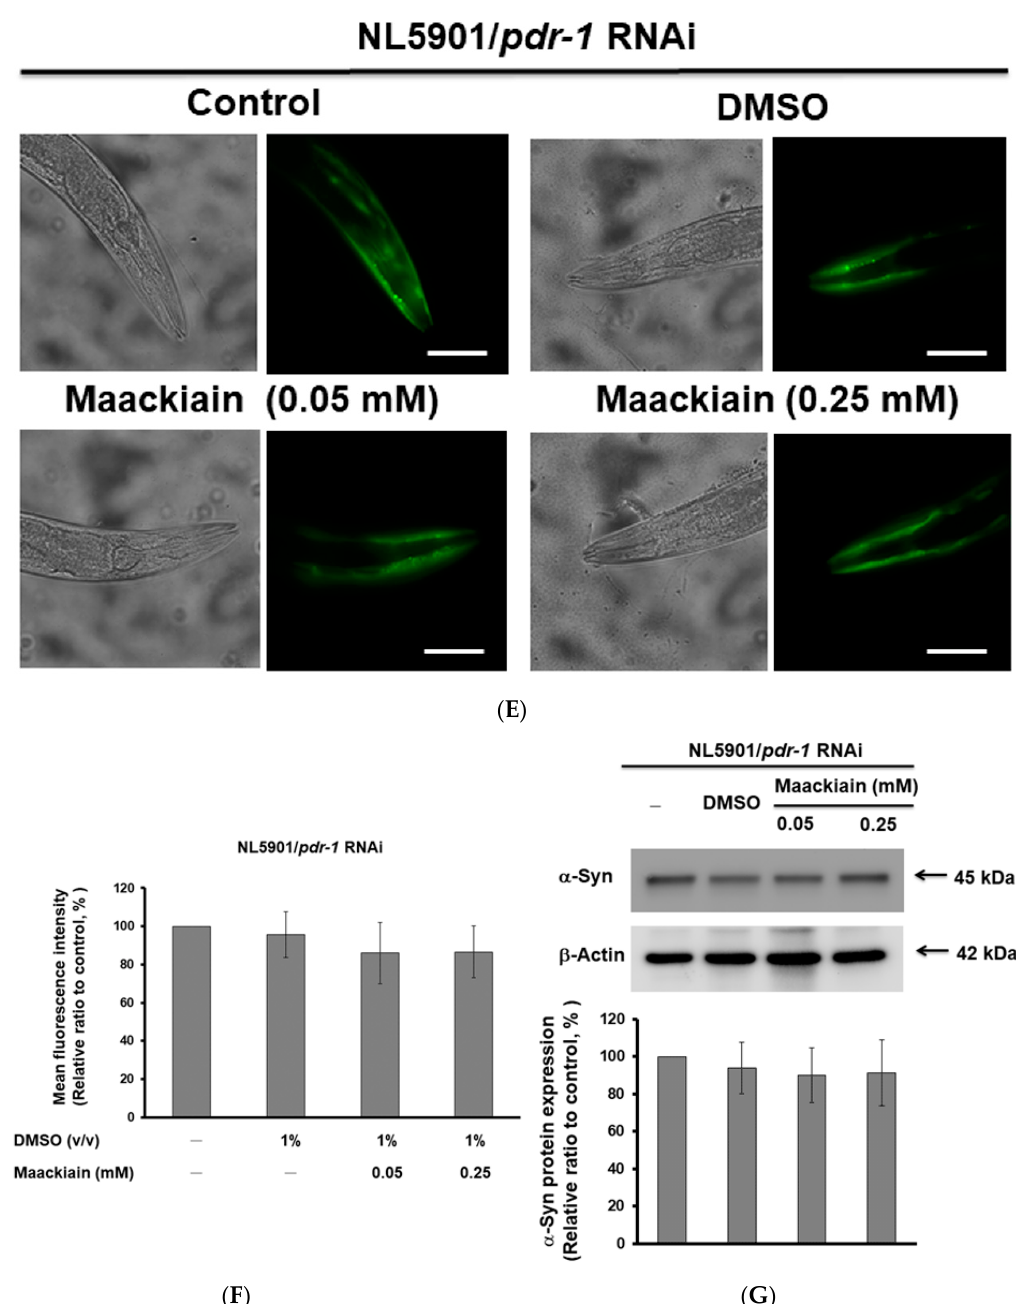
Figure 7. Using RNA interference (RNAi) approaches to downregulate the expression of pdr-1 lessened the ability of maackiain (MK) to ameliorate the pathology of Parkinson’s disease (PD) in C. elegans models. ( A ) Pdr-1 RNAi of BZ555 worms was performed by the method of feeding with bacteria expressing dsRNA. The mRNA level of pdr-1 was measured by qPCR. The expression of β ‐ actin was used as an internal control. * shows significant differences between the control RNAi ‐ treated and prd-1 RNAi ‐ treated worms (*** p < 0.001). ( B ) Representative GFP fluorescence images of DA neurons are shown from different experimental groups. Scale bar = 50 µm. ( C ) ImageJ software was used to quantify the GFP fluorescence intensity of DA neurons from different groups. Comparisons are between the MK ‐ untreated 6 ‐ OHDA ‐ exposed and MK ‐ pretreated 6 ‐ OHDA ‐ exposed group. # shows significant differences between 6 ‐ OHDA ‐ exposed and control worms (# p < 0.001) ( D ) Pdr-1 RNAi of NL5901 worms was performed by the method of feeding with bacteria expressing dsRNA. The mRNA level of pdr-1 was evaluated by qPCR. The expression of β ‐ actin was used as an internal